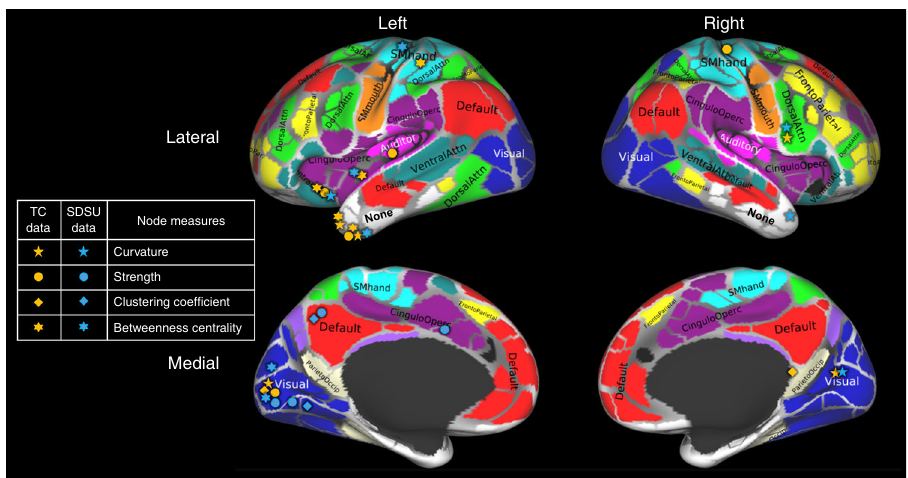
Fig. 4 Nodes with statistically signi fi cant differences (corrected for multiple comparisons using the Holm – Sidak method) in structural connectivity between individuals with ASD and TD subjects. Nodes identi fi ed using either the San Diego State University (SDSU) or the Trinity Center for Health Sciences (TC) data are shown in different colors (blue and orange, respectively). Brain parcellation with 333 cortical areas was done using the Gordon atlas 25 and labeled using the Brain Analysis Library of Spatial maps and Atlases database https://balsa.wustl.edu/WK71. Adapted from Fig. 10 of Supplementary data from Gordon et al.